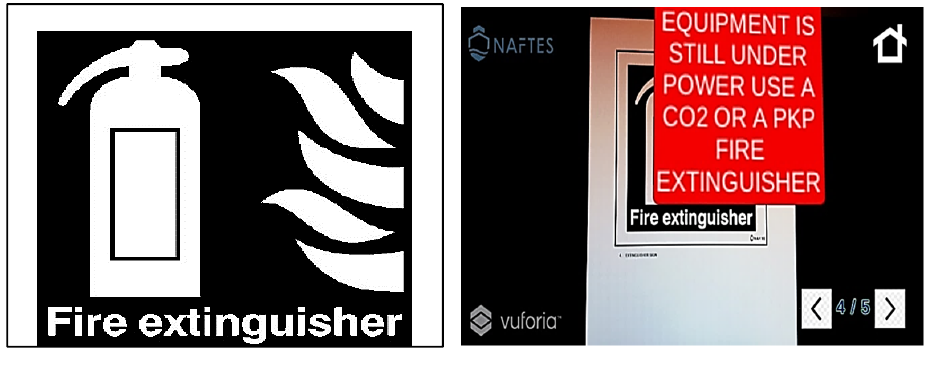
Figure 4. Fourth screen of a scenario of fire on an electrical circuit. ( a ) Printed target sign, and ( b ) the corresponding instructions that appear in the firefighters’ view.